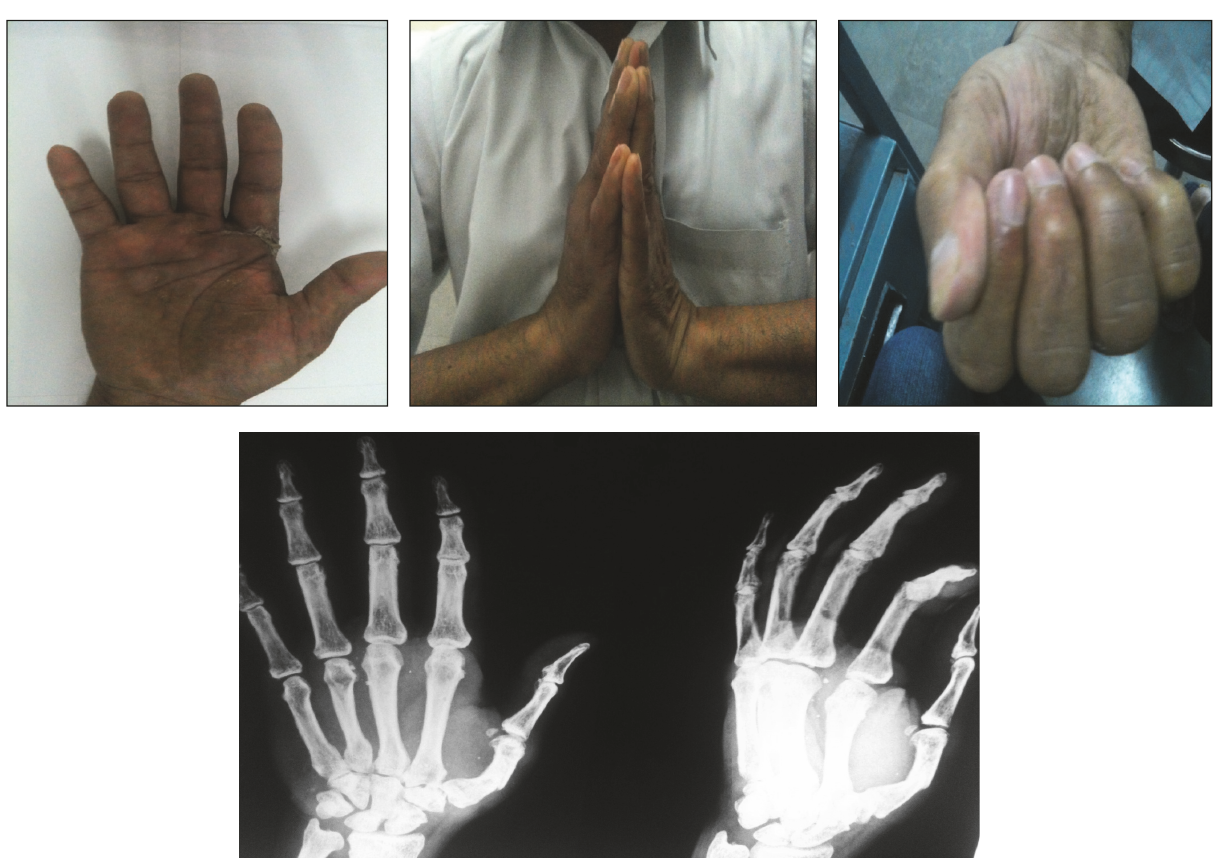
Figure 4: Clinical picture and X-ray at 3